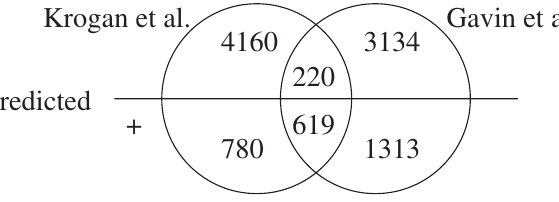
Figure 5. Enrichment of reliable pairs in predicted positives. The figure shows the number of protein pairs in the APMS datasets of Krogan et al. and Gavin et al. that are predicted to be negative (above the line) or positive (below the line) by our approach. Pairs from the MIPS training set are excluded. The predicted positive set is enriched with reliable pairs that are identified by both